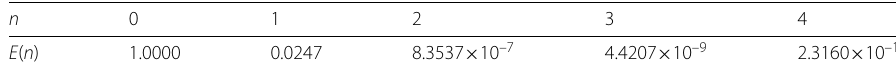
Table 1 The performance of the error value E ( n ), for example n 0